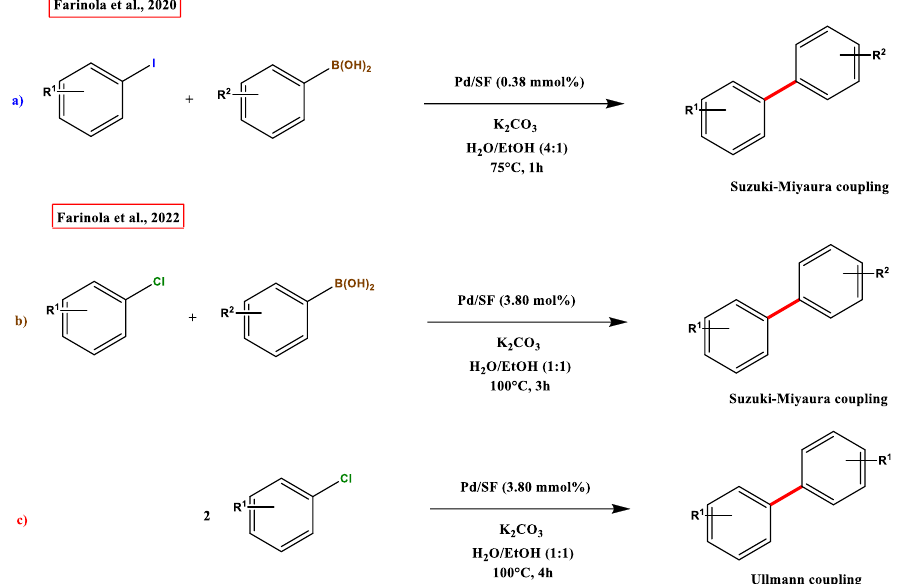
Figure 12. Comparison between reactions. ( a ) aryl halide (1.1 mmol), arylboronic acid (1.6 mmol), K 2 CO 3 (0.16 mmol), Pd/SF (0.38 mmol%), 2.5 mL H 2 O/EtOH (4:1), 75 ◦ C, 1 h; ( b ) aryl chloride (1.10 mmol), arylboronic acid (1.6 mmol), K 2 CO 3 (1.6 mmol), Pd/SF (3.8 mol%), 25 mL H 2 O/EtOH (1:1), 100 ◦ C, 3 h; ( c ) aryl chloride (1.10 mmol), K 2 CO 3 (1.6 mmol), Pd/SF (3.8 mol%), 25 mL H 2 O/EtOH (1:1), 100 ◦ C, 4 h. Adapted from References [61,62]. Copyright 2020, Wiley and 2022,